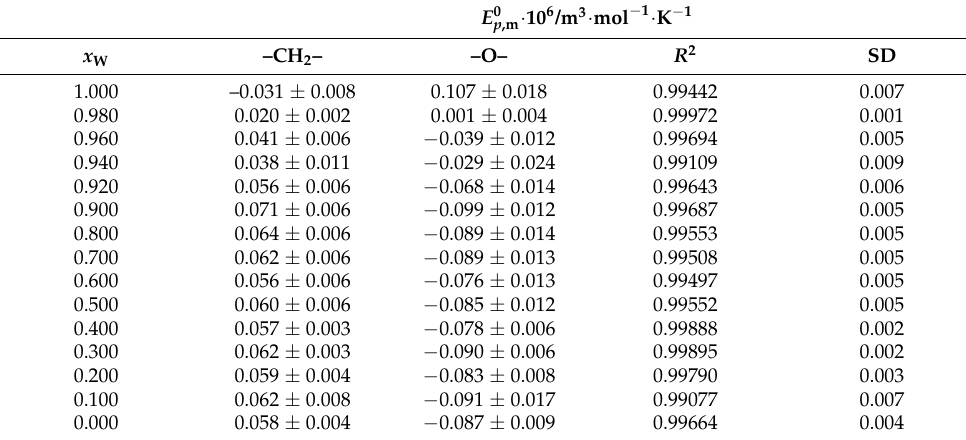
Table 11. The average effect of interaction between the –CH 2 – or –O– group and molecules of the DMF + W mixed solvent in E 0 p ,m at 298.15 K.